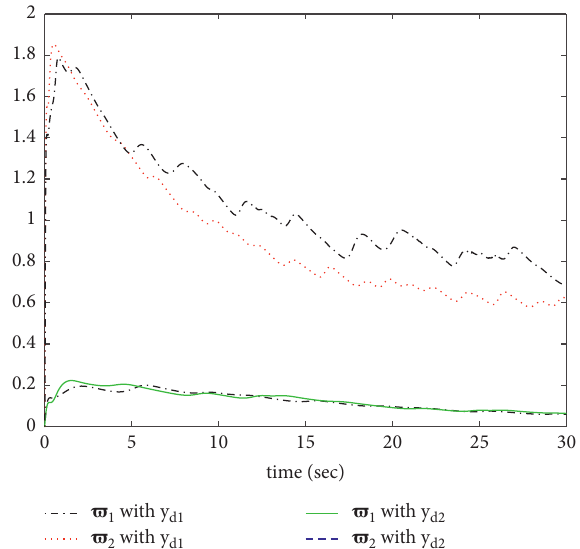
Figure 10: The adaptive parameters ϖ